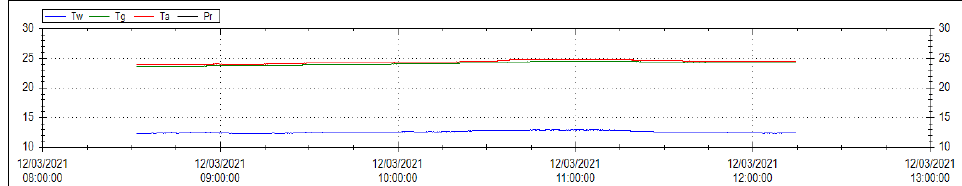
Figure 2. Example of the raw time series recorded by the DeltaOHM indoor microclimate system during the practical works of Group D (Tw — wet bulb temperature with natural ventilation; Tg — globe thermometer temperature; Ta — ambient temperature; Pr — vapor pressure). ment for groups C and D compared to the other two groups. PMV varied between 0.4